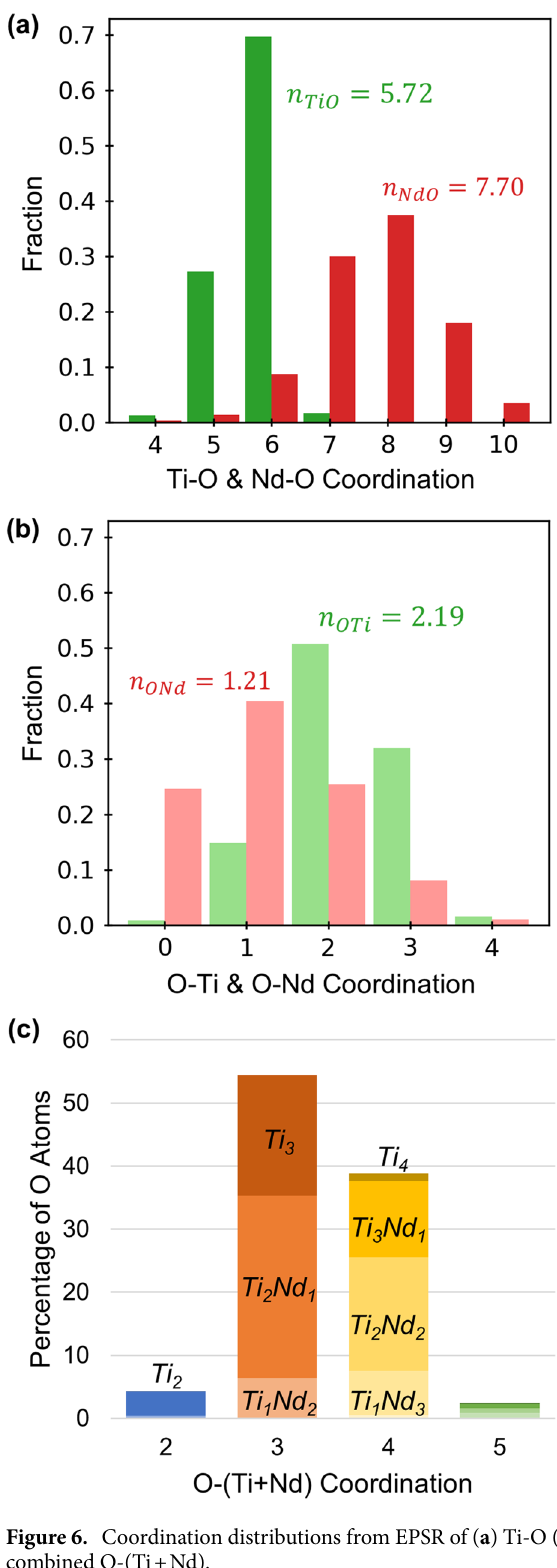
Figure 6. Coordination distributions from EPSR of ( a ) Ti-O (green) and Nd-O (red); ( b ) O-Ti and O-Nd; ( c ) combined O-(Ti +